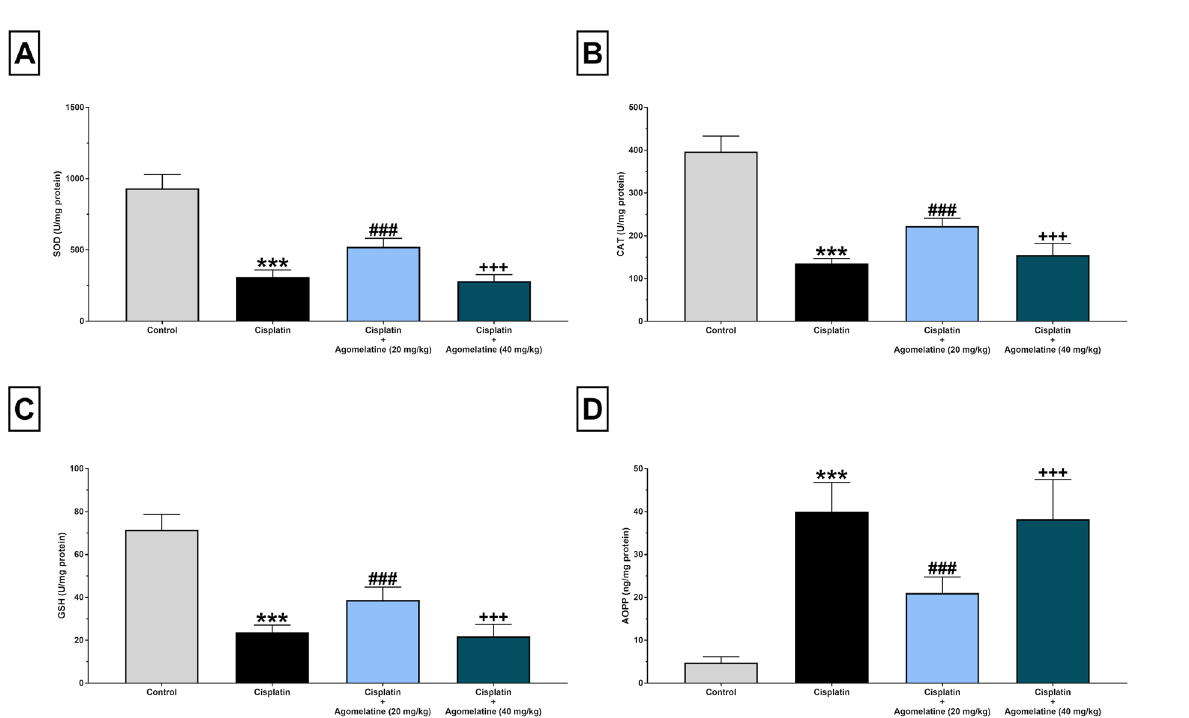
FIGURE 2 - Levels of antioxidant and oxidant markers in kidney tissue. A: Superoxide dismutase (SOD), B: Catalase (CAT), C: Glutathione-S-hydroxylase (GSH), D: Advanced oxidation protein products (AOPP). Agomelatine 20 and 40 mg/kg significantly attenuated cisplatin-induced oxidative stress and resulted in a decrease in antioxidant enzymes. All data represented as mean±SD and stand for five animals per group. *** p<0.001 versus control group and ### p<0.001 versus cisplatin group.